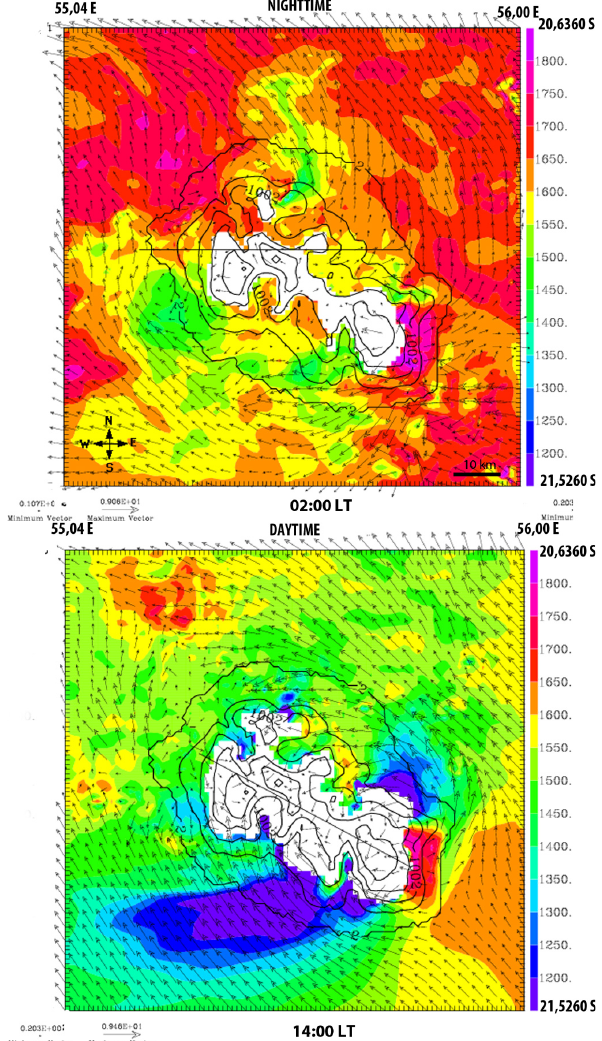
Fig. 9. Horizontal map showing the altitude of the 296K isentrope (colorscale in m) in the experiment ALIZ5 at 02:00LT (top) and 14:00LT